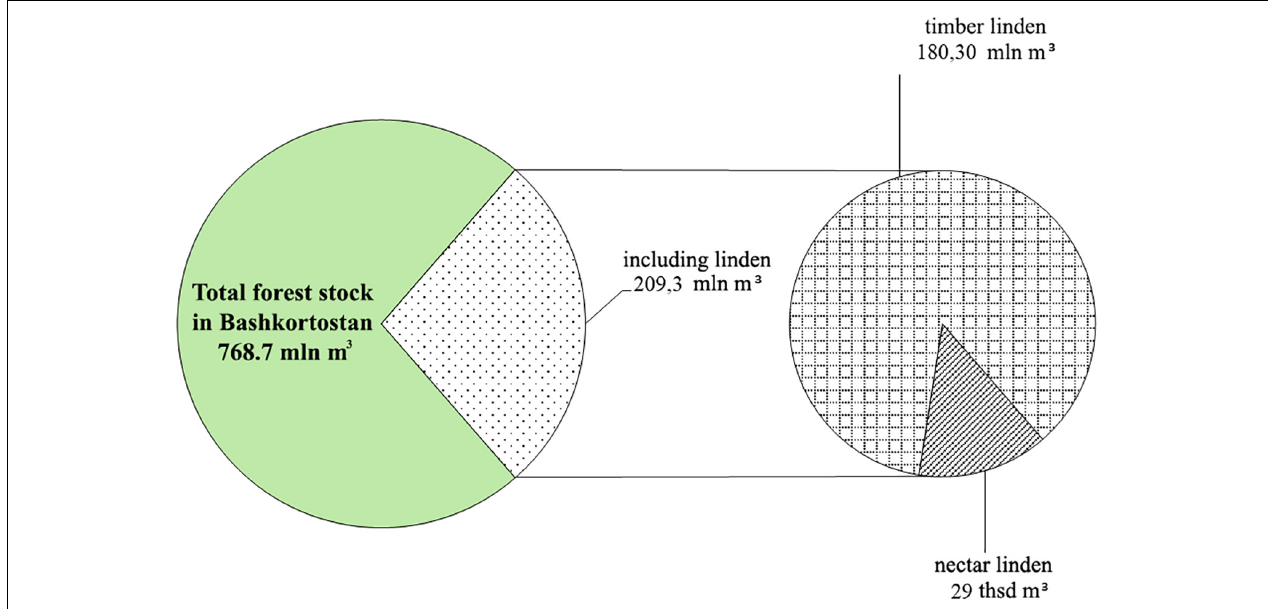
FIGURE 5 | Distribution of the total Tilia cordata Mill. wood stock by economic sections – commercial linden and nectar linden.